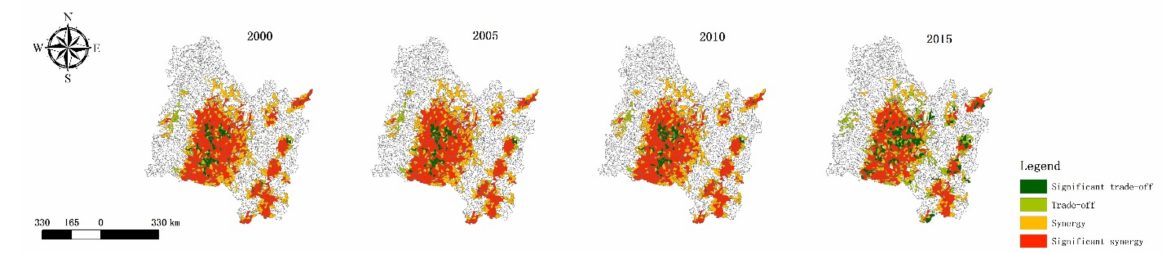
Figure 10. The synergy/trade-off relationship between water retention and soil conservation. The synergy/trade-off relationship between water retention and biodiversity in spatial